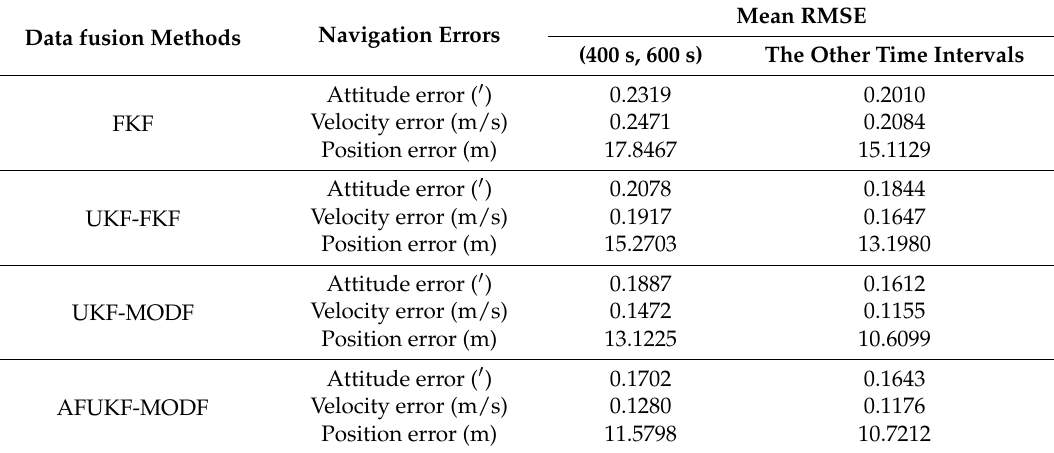
Table 2. Mean RMSEs of the overall estimation errors obtained by FKF, UKF-FKF, UKF-MODF and AFUKF-MODF for the simulation